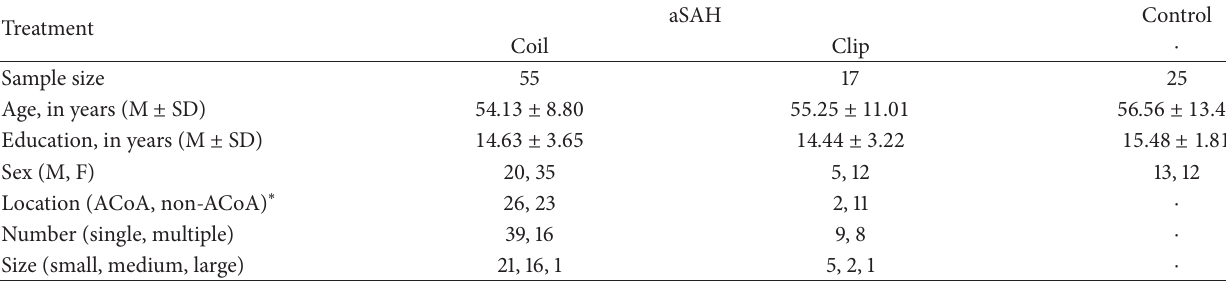
Table 1: Participant demographics and aneurysm